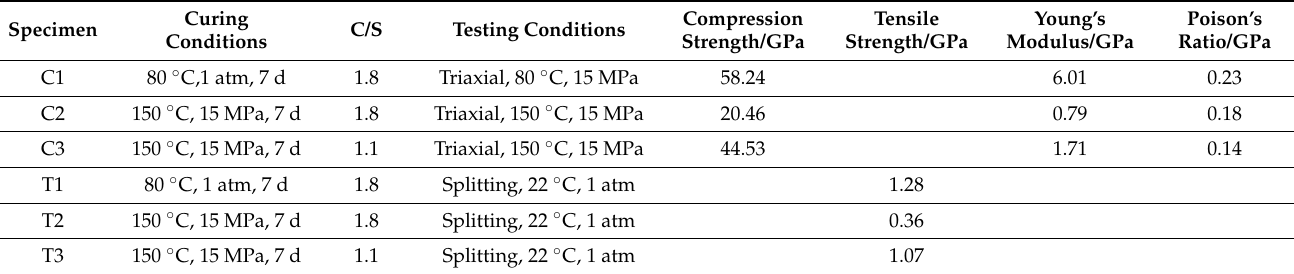
Table 2. Results of mechanical experiments under different conditions.